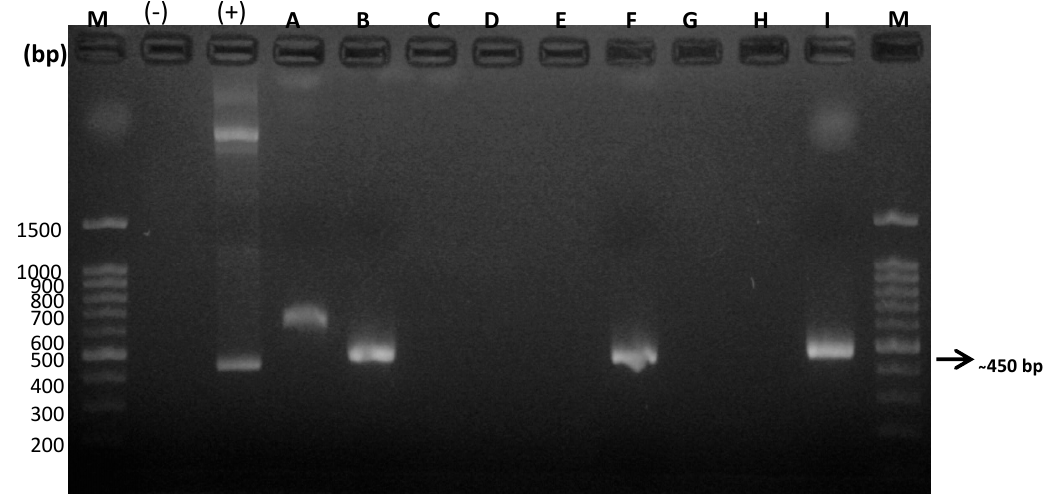
Figure 2. Amplification products obtained by PCR in a general assay for DNA samples obtained from cerebrospinal fluid (CSF) of domestic cats. M: Molecular weight marker; ( − ): Negative Control; (+): Positive control; bp: base pairs; A → I: domestic cats analysed in this reaction.